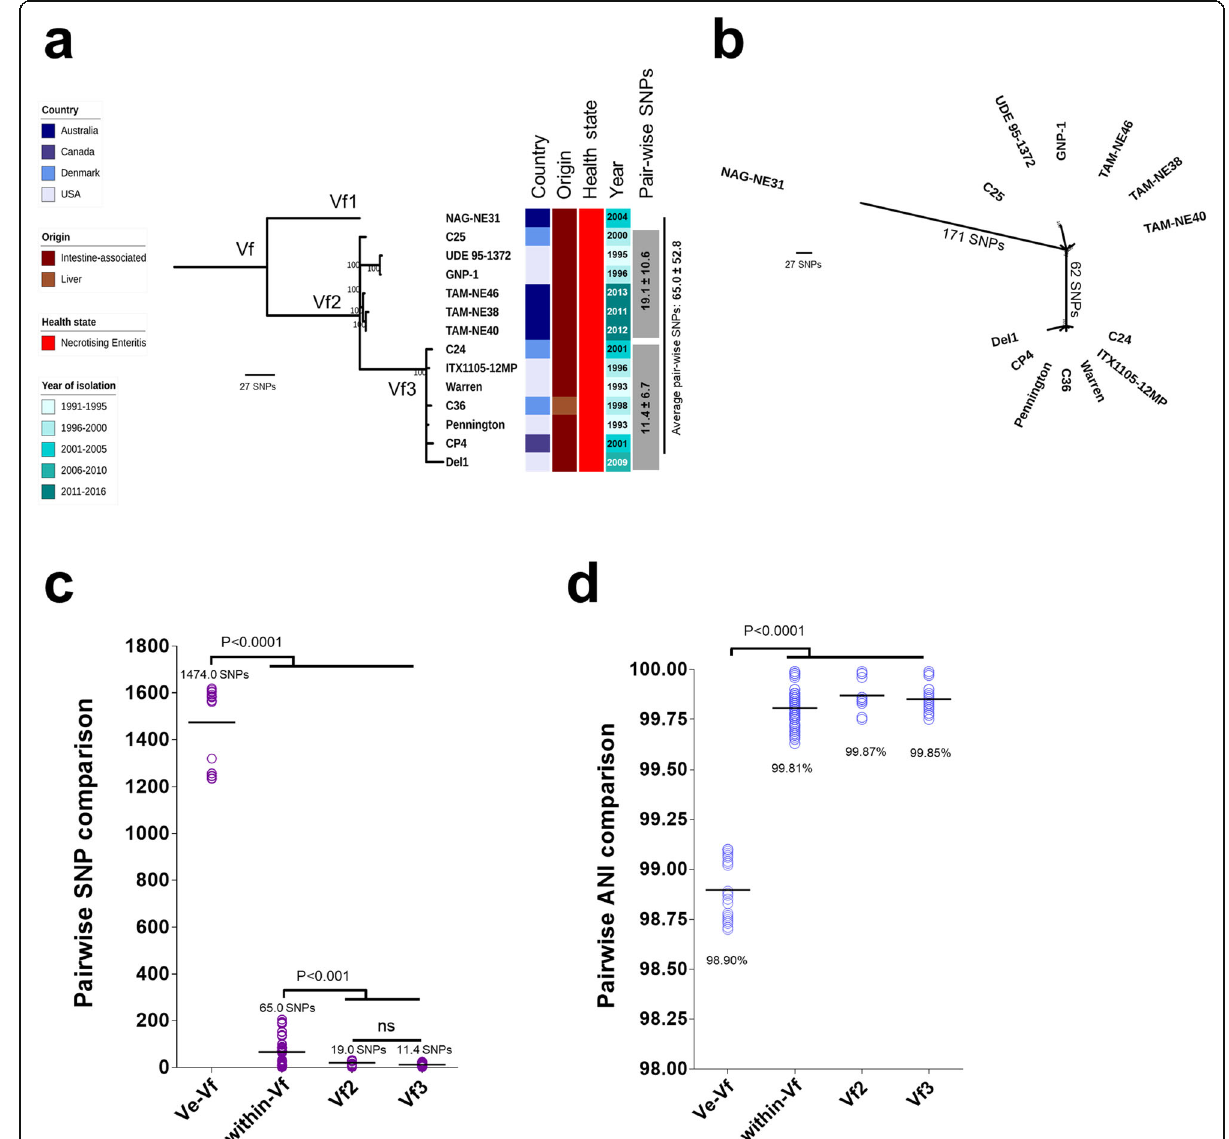
Fig. 2 a Mid-point rooted maximum-likelihood tree based on 228 SNPs of 14 genomes (in 1810 core genes) in lineage Vf, labelled by country, origin, host health state, year of isolation and within-lineage pair-wise SNP comparison. Data: Mean ± S.D. b Unrooted ML tree indicating SNP distance in between major branches. c Pair-wise SNP comparison between isolates in sub-lineages Ve vs Vf, and within sub-lineage Vf. d Genome-wide pair-wise ANI comparison between isolates in sub-lineages Ve vs Vf, and within sub-lineage Vf. Data: Kruskal-Wallis test, Dunn multiple comparison. Means were indicated in each